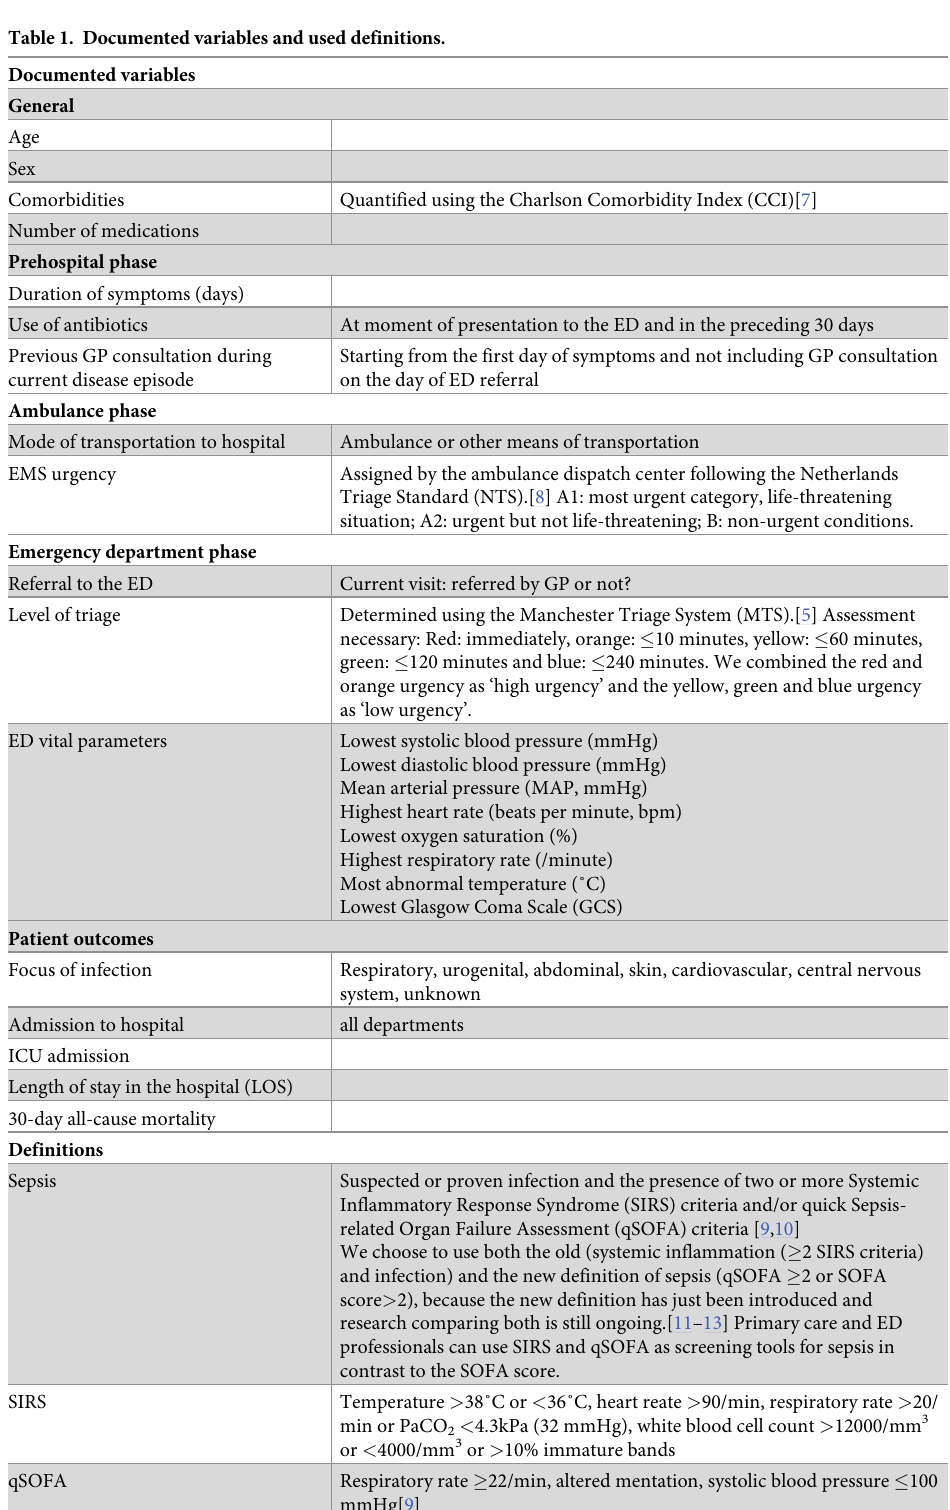
Table 1. Documented variables and used